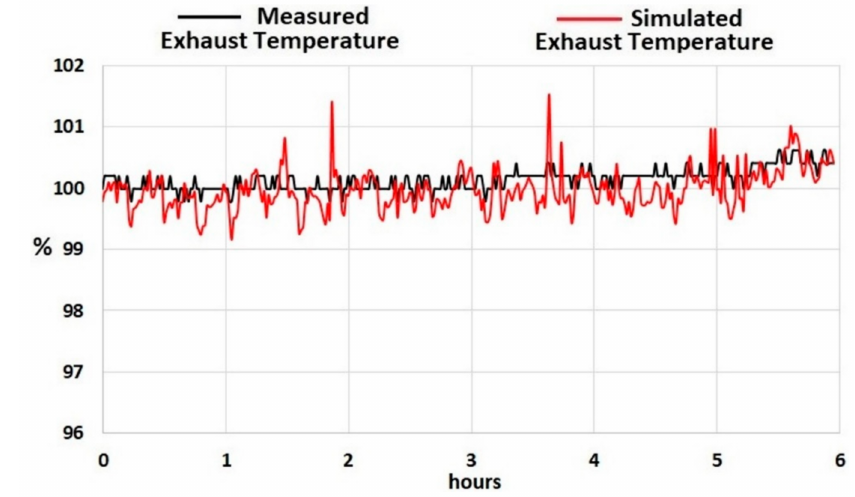
Figure 39. Measured and simulated compressor exhaust temperatures at high IGV